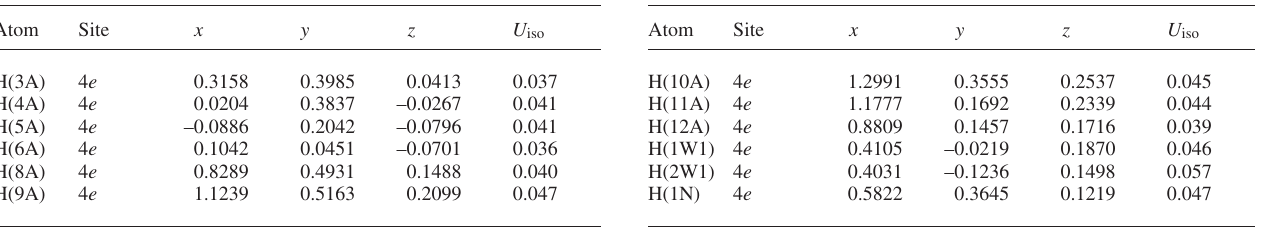
Table 2. Atomic coordinates and displacement parameters (in Å 2 ) . Table 2. Continued